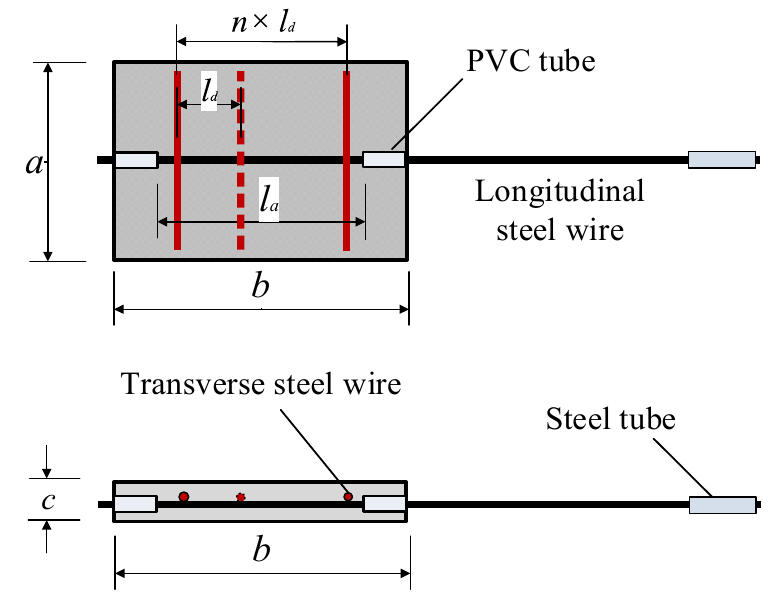
Figure 2. The diagram of specimens.